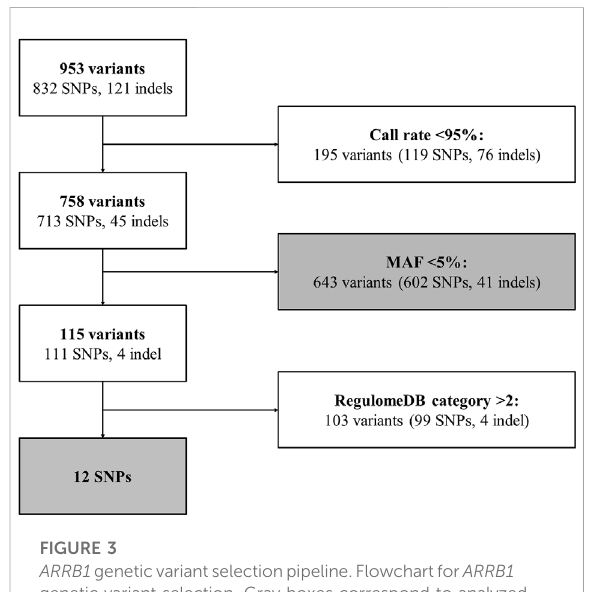
FIGURE 3 ARRB1 geneticvariantselectionpipeline.Flowchartfor ARRB1 genetic variant selection. Gray boxes correspond to analyzed variants. Indel, insertion/deletion; MAF, minor allele frequency; SNP, single nucleotide